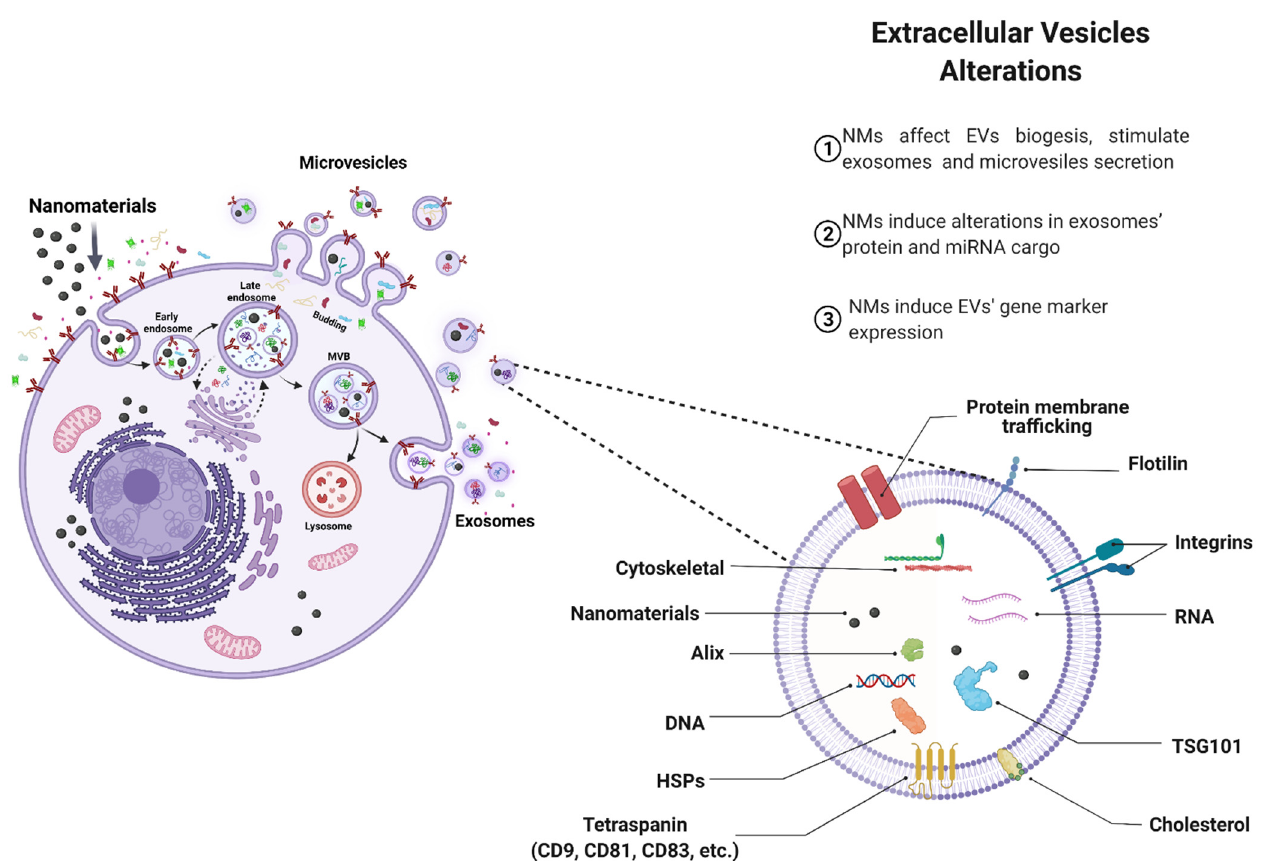
Figure 2. Schematic representation of the overall effect of NMs on secreted EVs.